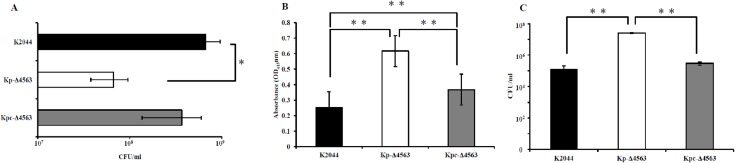
Phenotype and adhesion assays of KP1_4563.(A) Hemagglutination assays. Mannose-resistant hemagglutination (MRHA) assays were performed with human erythrocytes. The results are expressed as the minimum bacterial density (CFU/ml) required to cause a visible agglutination reaction. Values represent the mean of three independent experiments, and the error bars represent standard deviation. P values were calculated by one-way ANOVA and Tukey HSD post hoc comparisons. (B) Mannan-binding assay. Mean values and standard deviation of six technical replicates are showed. P values were calculated by one-way ANOVA and LSD post hoc comparisons. (C) Bacterial adhesion assays. Data are the means of measurements made in technical triplicates. Error bars represent the standard deviation. P values were calculated by one-way ANOVA and LSD post hoc comparisons. Significant differences are indicated by * for P<0.05 or ** for P<0.01.